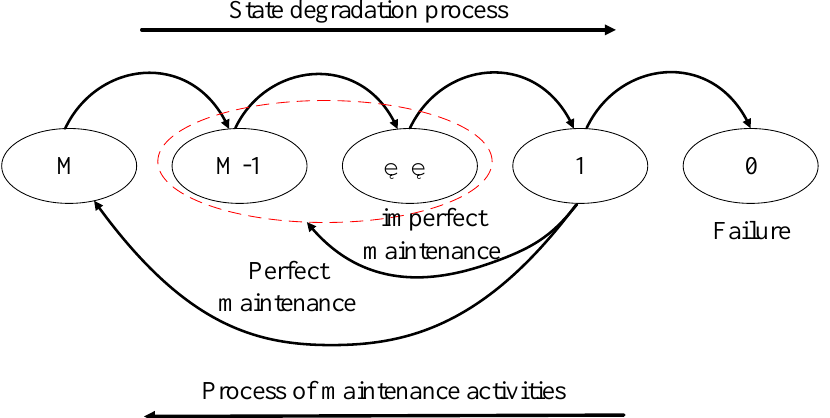
Figure 2. Preparation of state degradation and maintenance